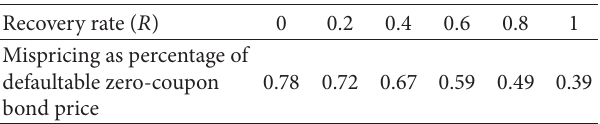
Table 2: Effect of recovery